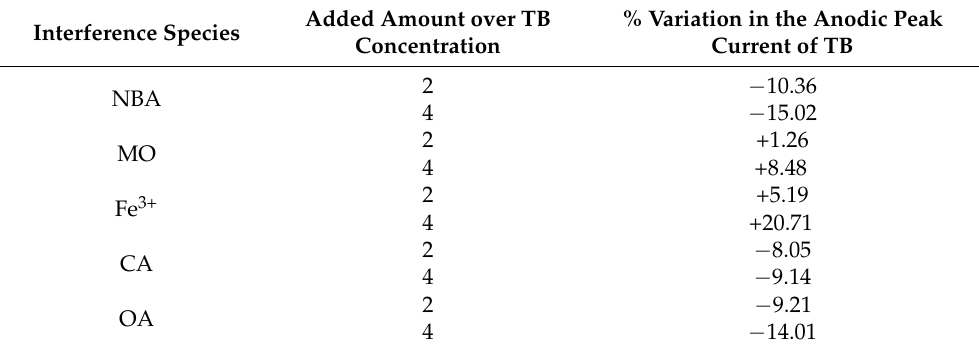
Table 4. Highlighting the influence of other species on the GCE/Lys/HA sensor response using TB at 5 × 10 − 6 mol/L TB in 0.1 M PBS pH